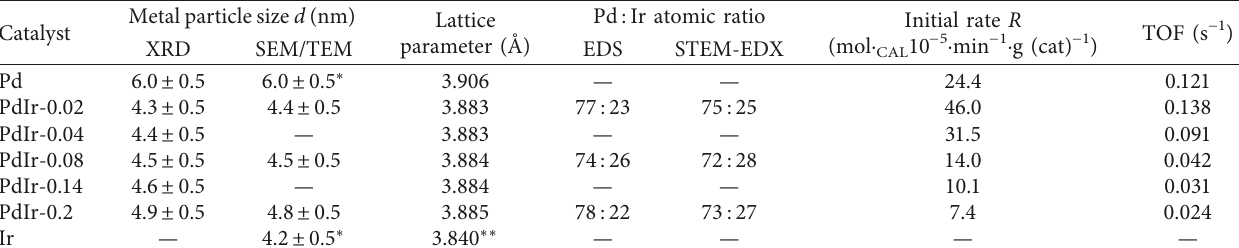
Table 1: Physicochemical properties of investigated catalysts: metal particle characterization (average size, the overall composition measured by EDS, and the local composition measured by STEM-EDX methods) and the initial rate of cinnamaldehyde hydrogenation. Metal particle size d (nm) Catalyst